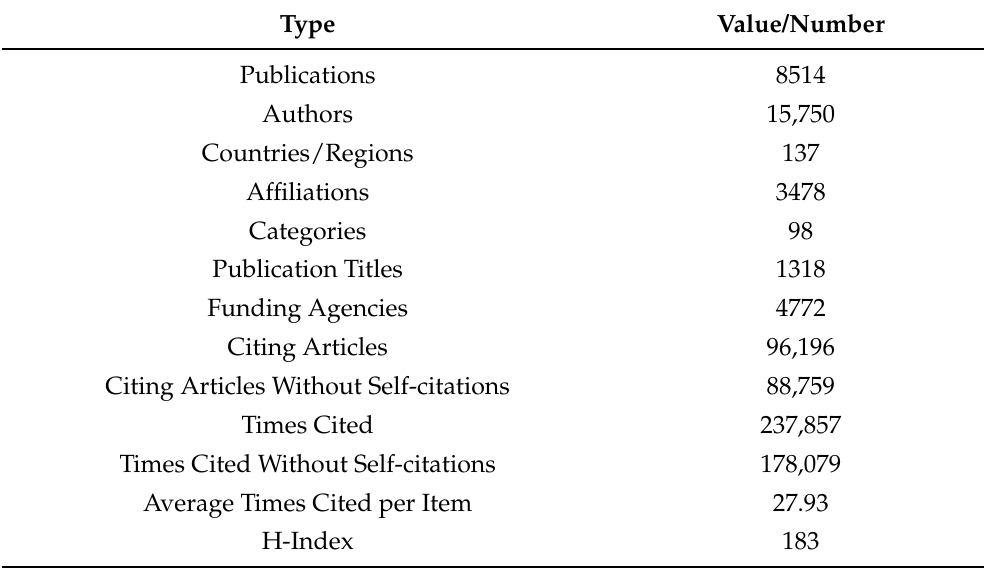
Table 1. Basic information of the WoS data set in the field of satellite altimetry from 1970 to